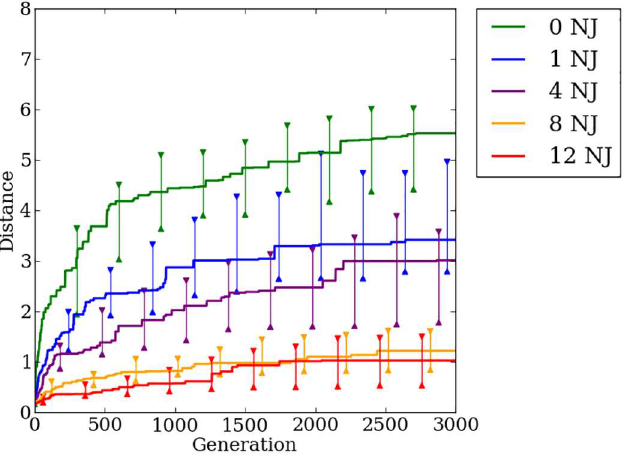
Fig 23. The median distance traveled by Offset-HybrID generation champions over 3,000 generations on the quadruped robot transfer experiment. The line colors indicatethe number of noisy joints on the robot. 95% bootstrappedconfidenceintervals of the medianare shown every 300